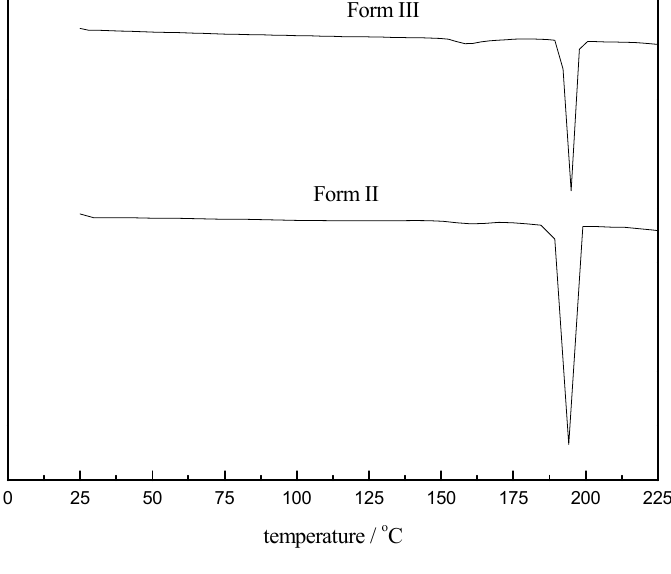
Figure 2. Differential scanning calorimetric curves of carbamazepine